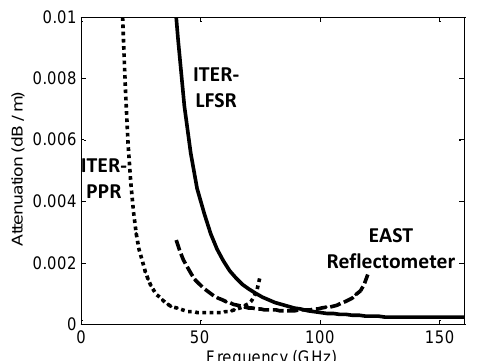
Fig. 12. Theoretical HE 11 attenuation in 6061-T6 aluminium for ITER PPR waveguide (dotted), EAST reflectometer waveguide (dashed), and ITER LFSR waveguide (solid).